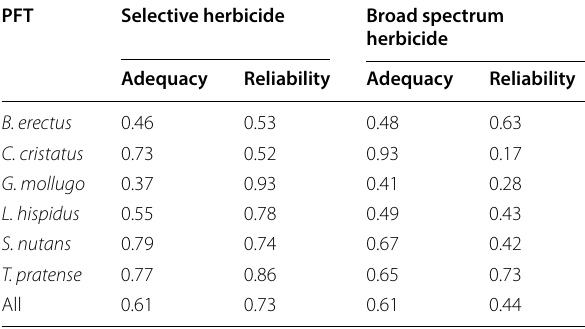
Table 7 Model fit for the